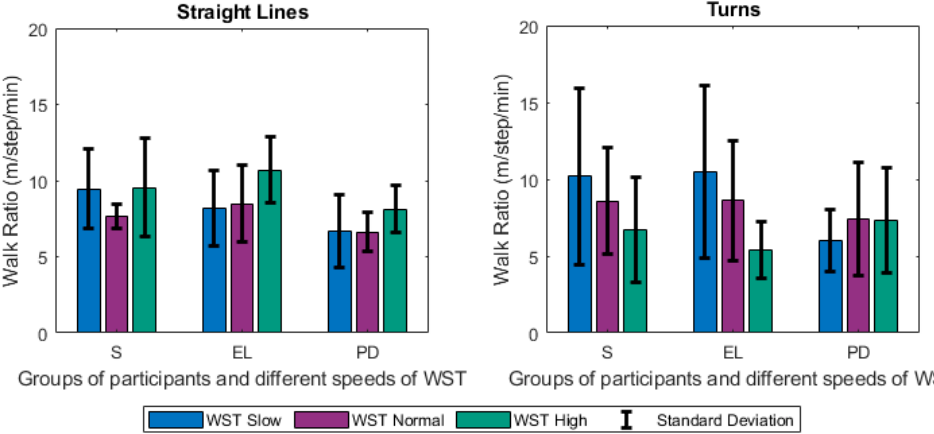
Figure 8. Changes of the Walk Ratio (m/step/min) for Straight Lines and Turns (mean values along with standard deviations) between the different groups of participants (S, EL, PD) and the different speeds of the WST test (slow, normal,